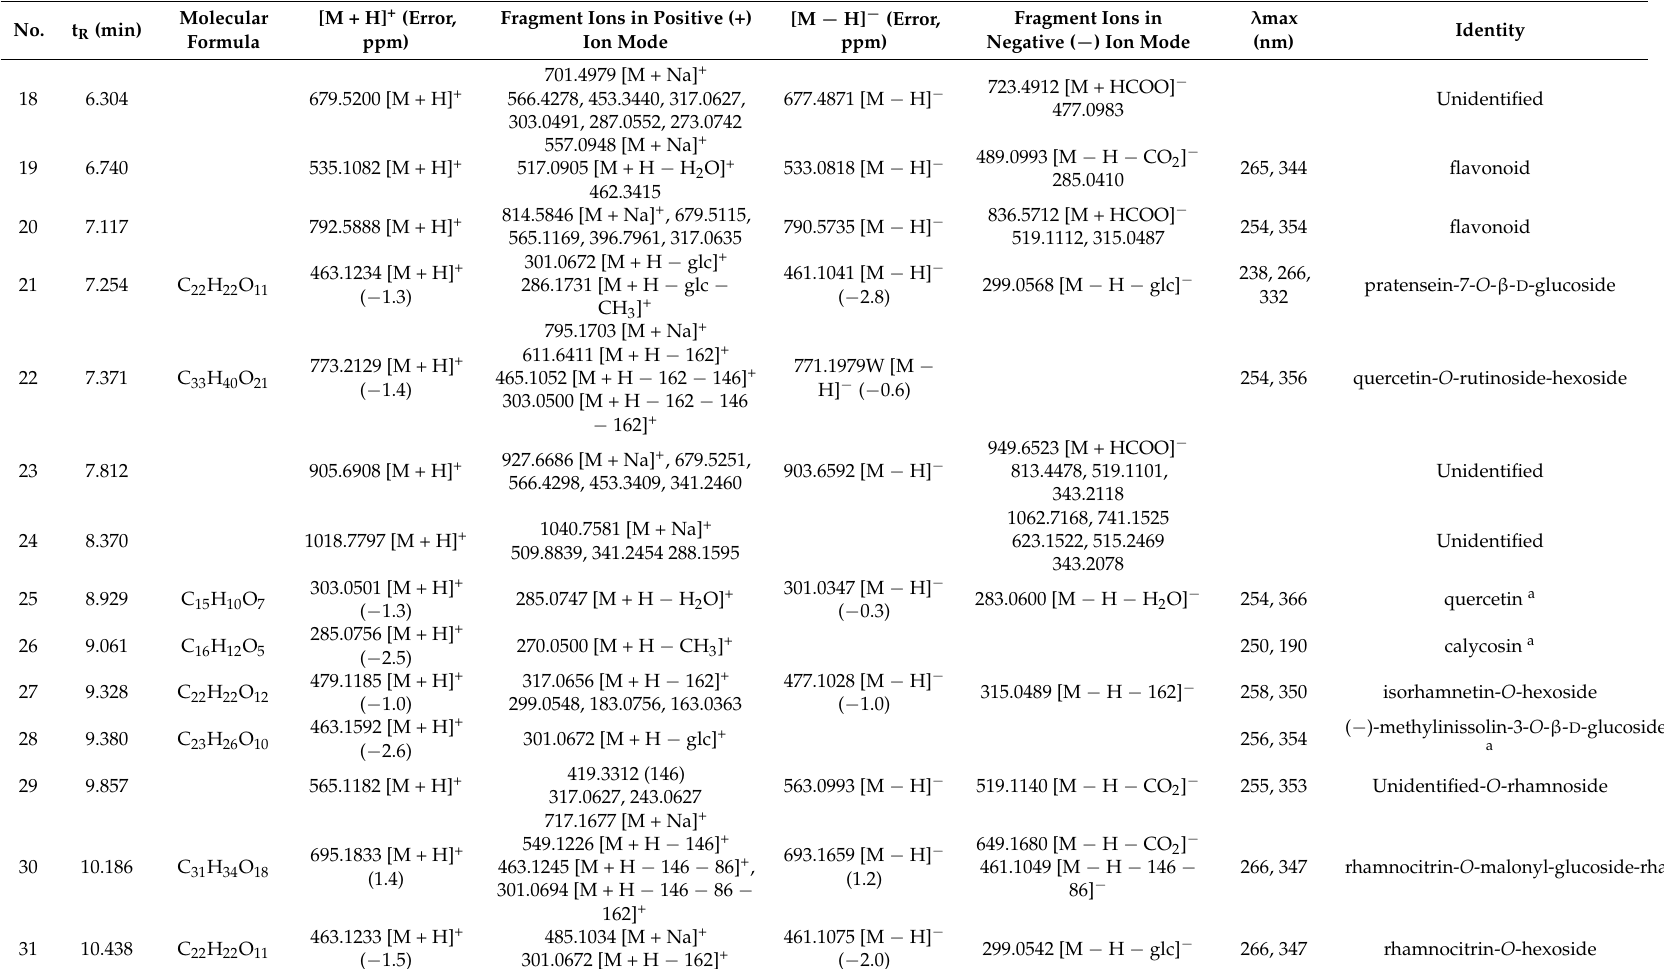
Table 2. Compounds identified in ME of AMF by UPLC-Q-TOF MS